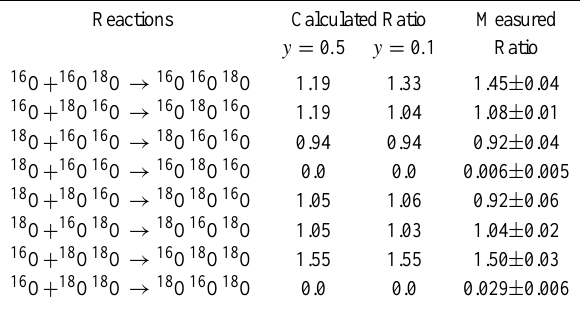
Table 4. Comparison between calculations performed for isotopi- cally non-fractionated (column 1) and fractionated (column 2) oxy- gen atoms in a scrambled gas. The calculations were performed at 60 Torr with the parameters reproducing the isotopomer specific rate coefficients (Mauersberger et al., 1999; cf. Table 3). Recent data at 60 Torr on all ozone isotopomers are reported for compari- son (Wolf et al., 2000). The difference between the results in col- umn 2 and the measured isotopic composition are reported in the last column ( 1 )